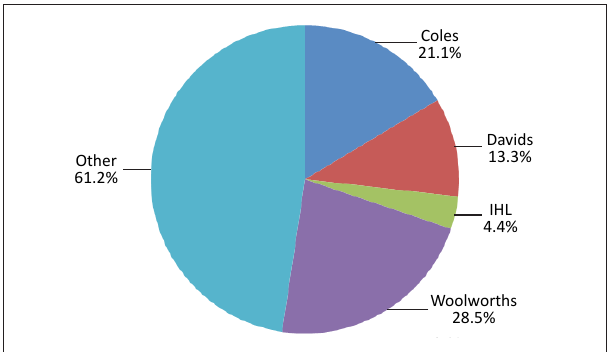
FIGURE 2: Survey item number 2 – nationwide retail grocery market shares.